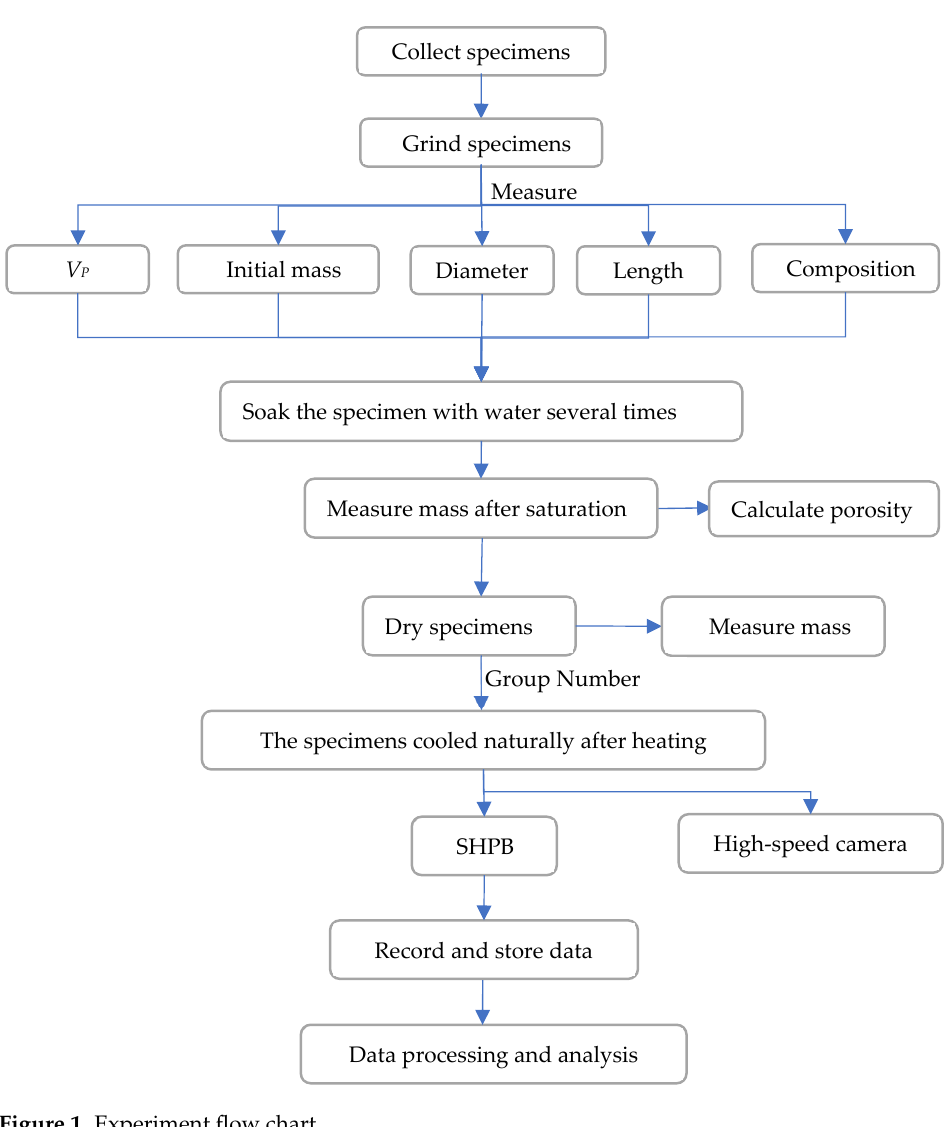
Figure 1. Experiment flow chart.